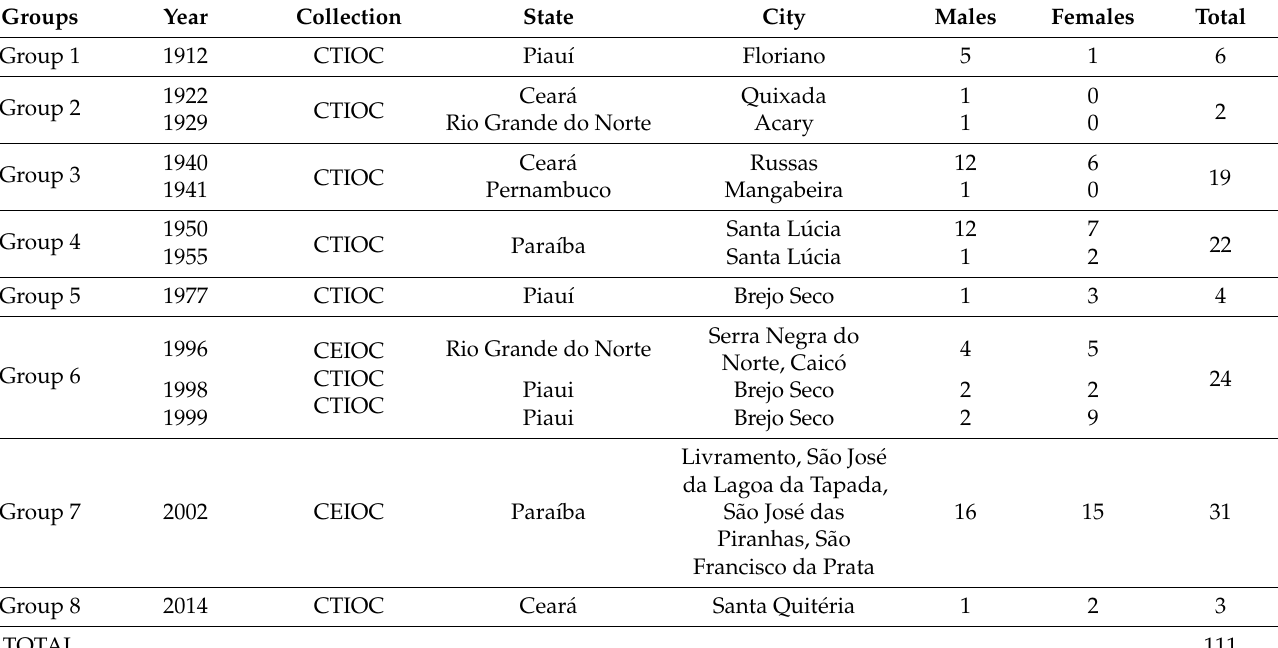
Table 1. Localities and years of the left-wing samples of Triatoma brasiliensis brasiliensis used for this study. Availability of samples were arranged chronologically, abbreviation are defined as CEIOC: the Entomological Collection of Instituto Oswaldo Cruz and CTIOC: the Collection of Triatomines of Instituto Oswaldo